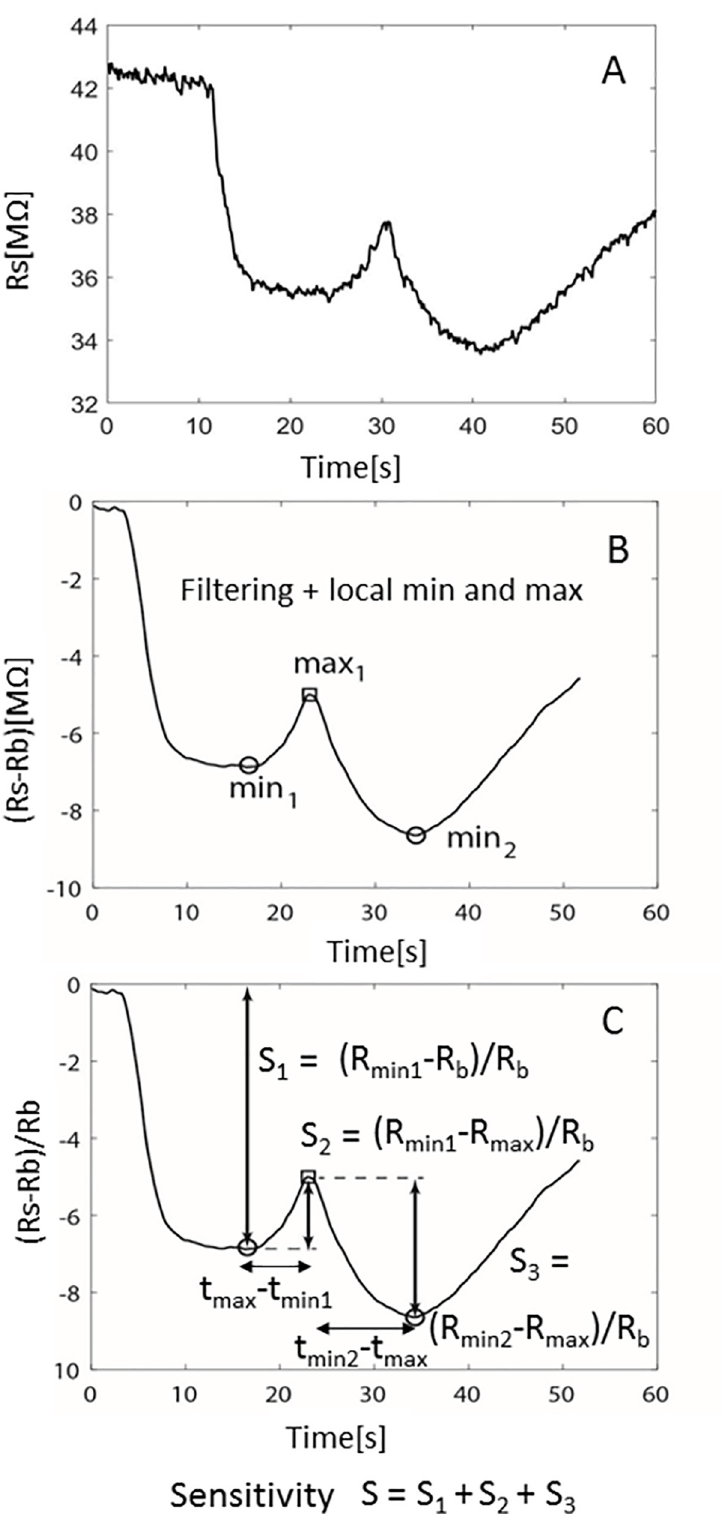
Fig 3. Breathalyzer sensitivity for NO. A. Omega Pattern seen in critically ill patients with severe COVID-19 pneumonia. We start in air and have a baseline. B. As soon as breath reaches the sensor and until the ammonia